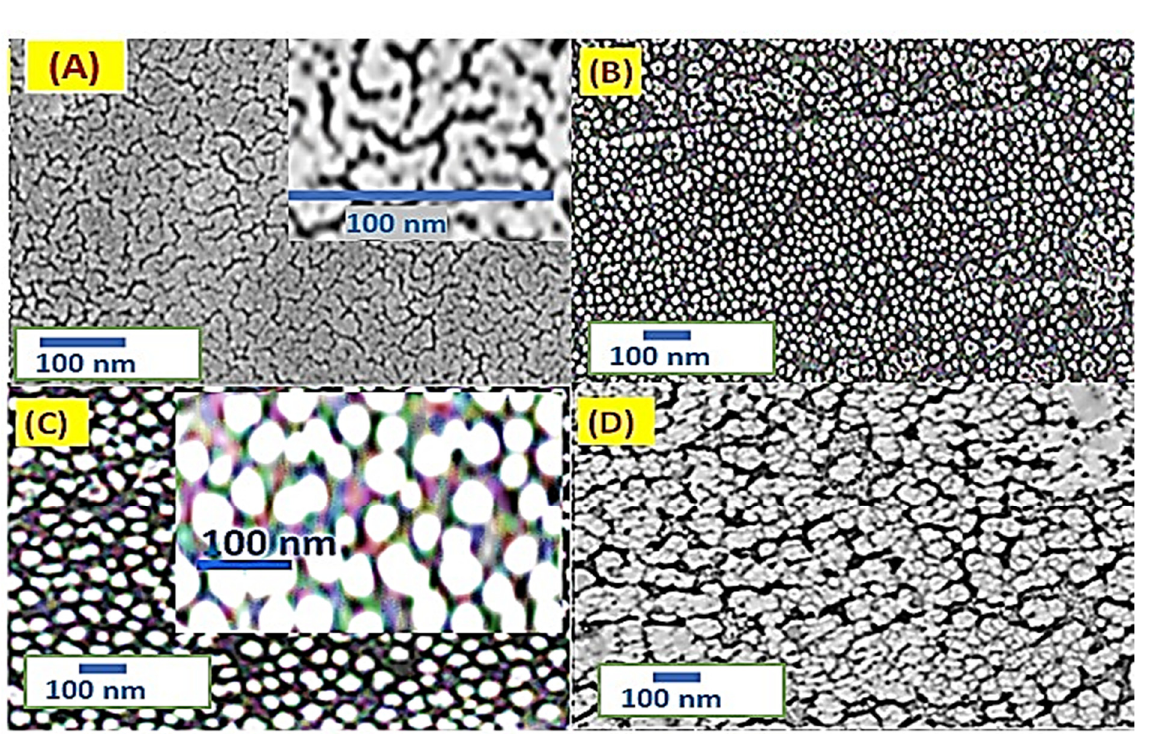
Figure 3. SEM images of PMT for Au coating with times of ( A ) 0, ( B ) 1, ( C ) 2, and ( D ) 3 min.